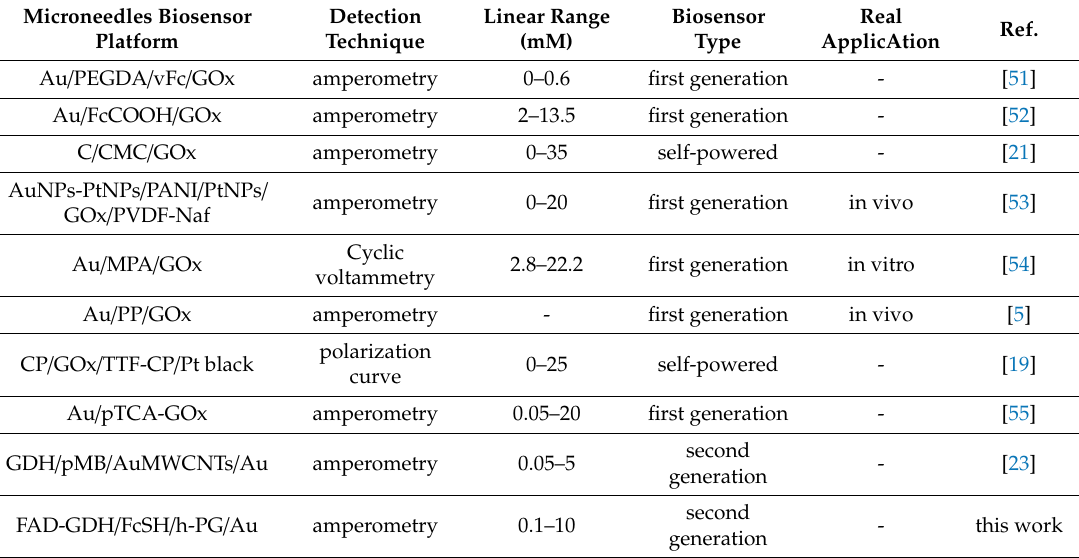
Table 2. Comparison between di ff erent microneedles-based biosensors for glucose